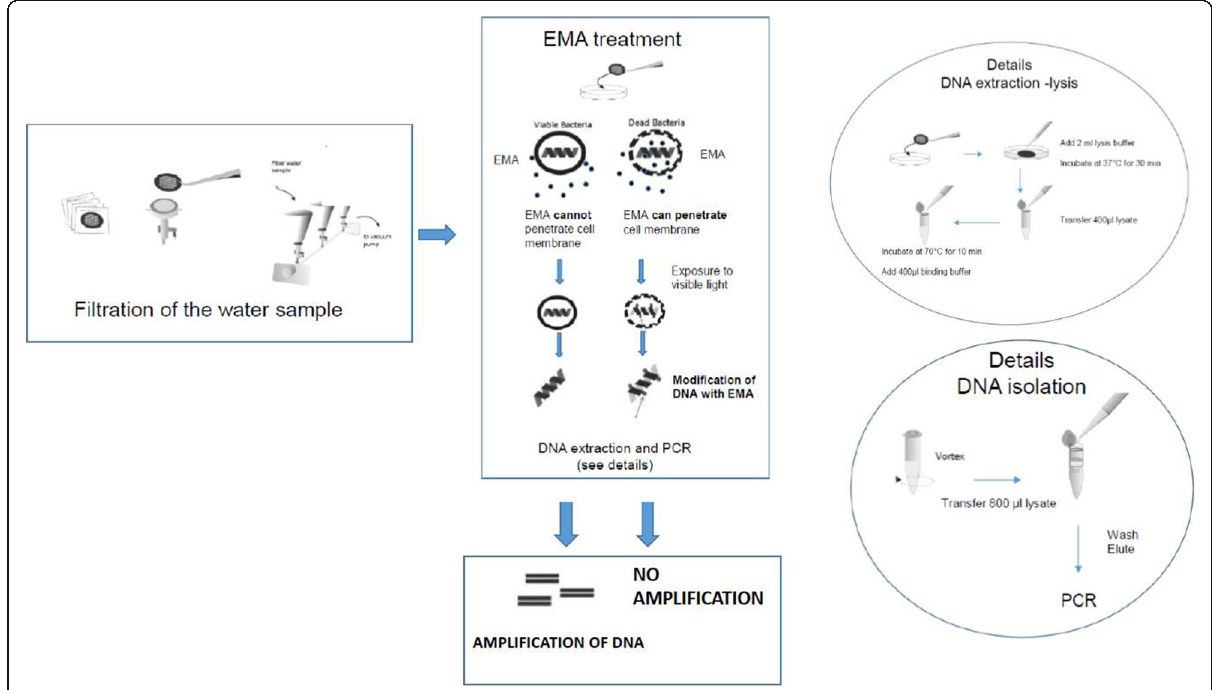
Fig. 1 Description of the modified EMA-qPCR